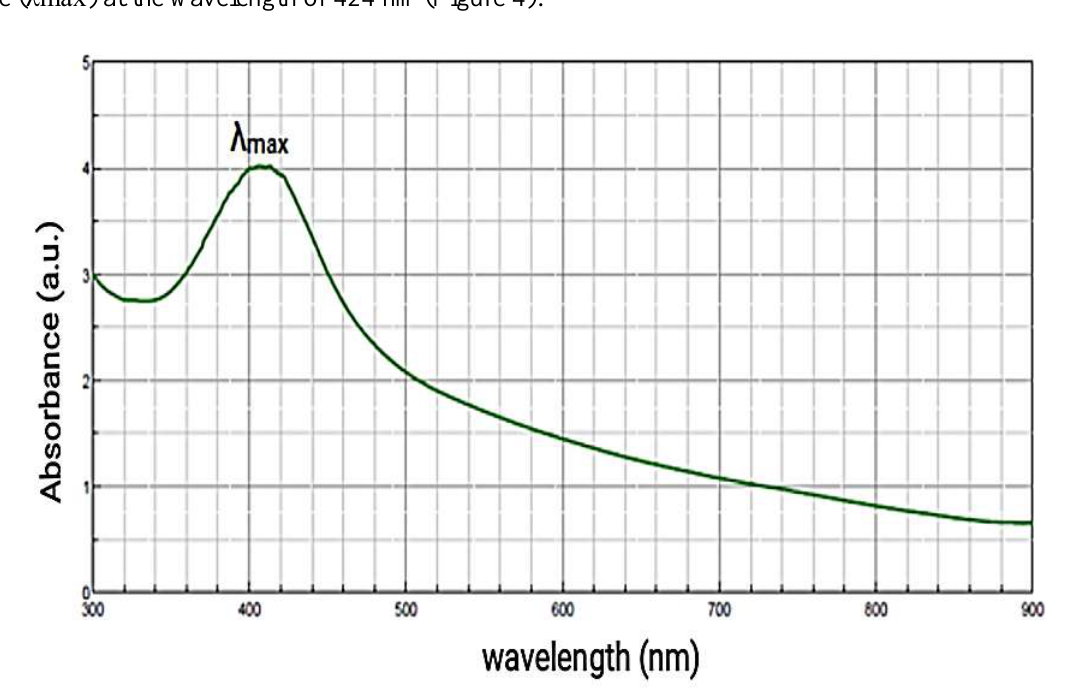
Figure 4: Characterization of silver nanoparticles using a UV visible